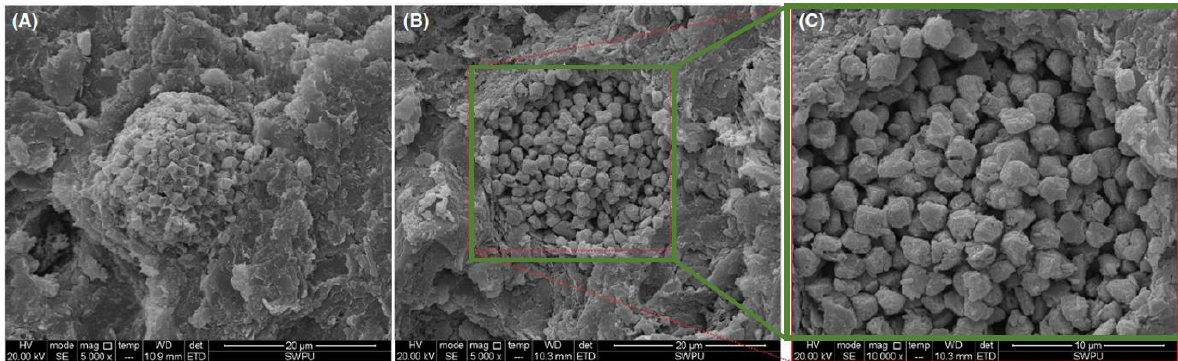
Figure 5. The component analysis of oil shale: ( A ) Origin morphology of pyrite, ( B ) morphology of pyrite after microwave heating with magnification lenses of 5000× and ( C ) morphology of pyrite after microwave heating with magnification lenses of 10,000× [85].